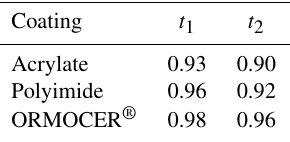
Table 8. Mean strain quotients in the comparison area at test times t 1 and t 2